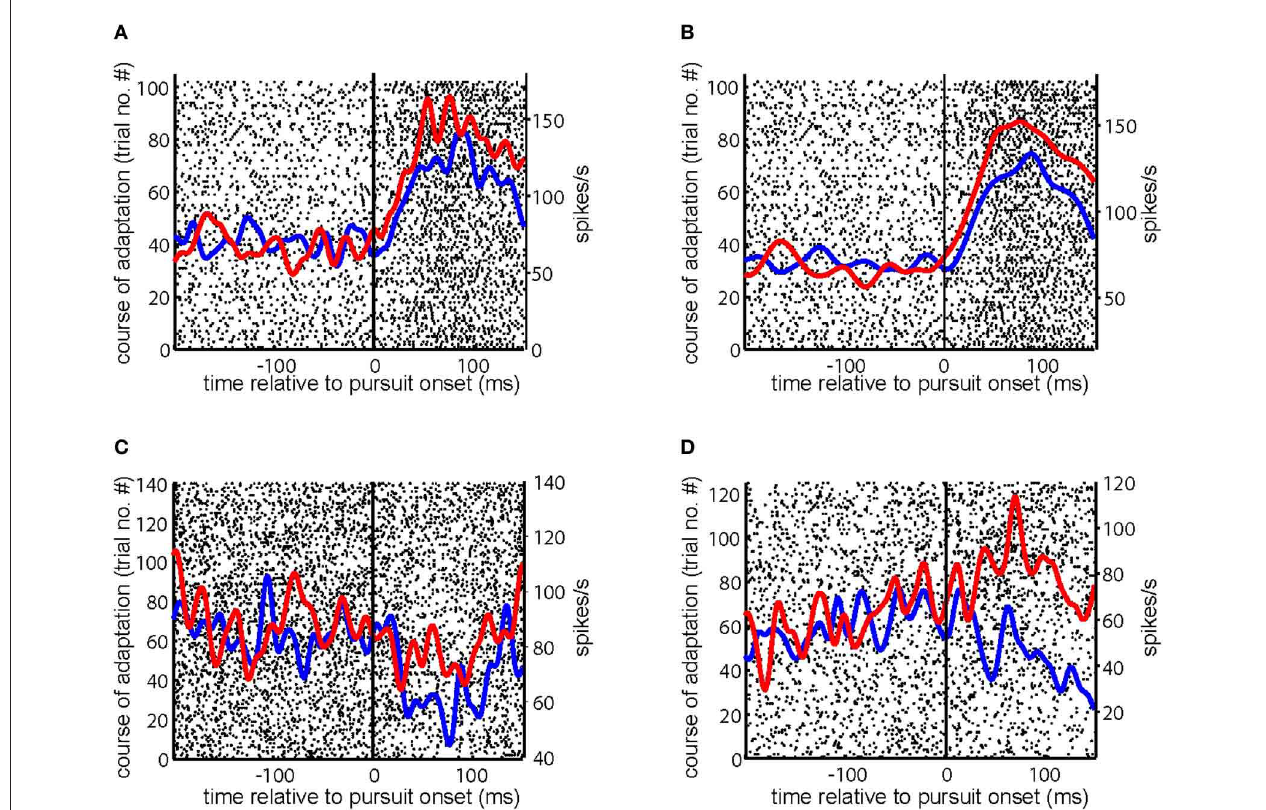
FIGURE 2 | Responses of exemplary PC SS during gain-increase SPA. (A–D) Show the raster plot of a PC SS during the course of gain-increase SPA with superimposed spike density functions for the